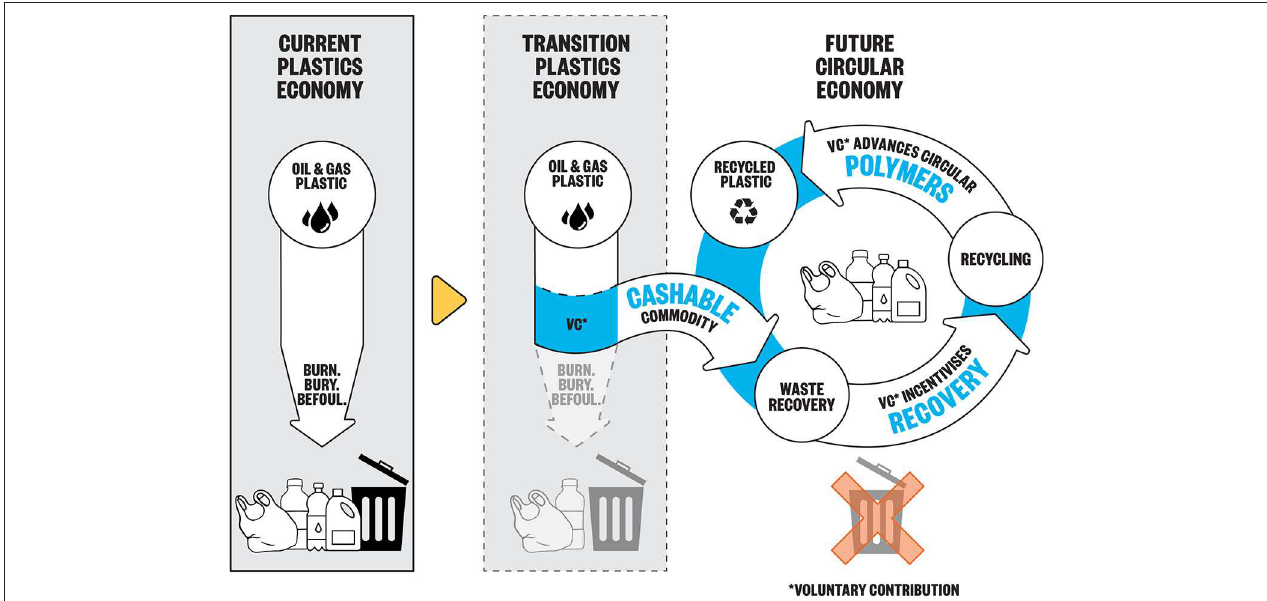
FIGURE 2 | Illustrations of the linear plastics economy (left), circular polymers economy (right), and transition plastic economy (center). Our proposed initiative will re-direct the flow of fossil fuel-derived plastics away from the environment and into the